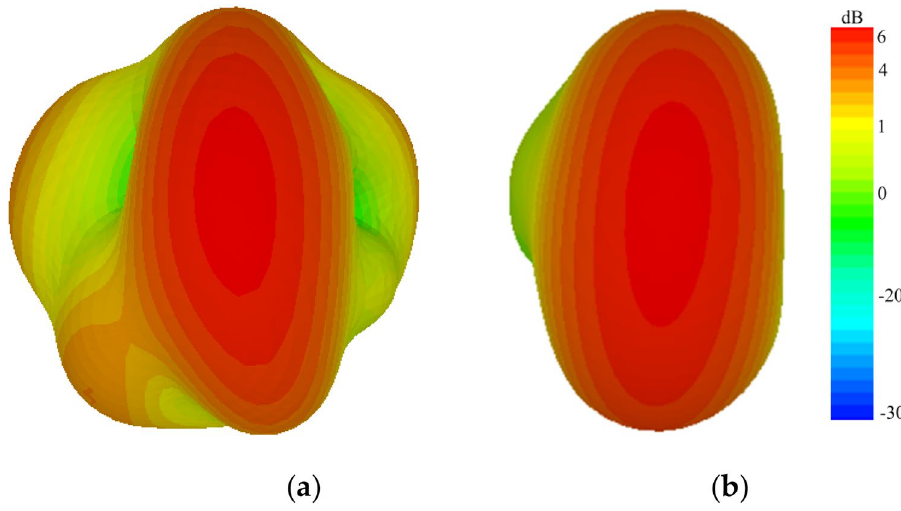
Figure 6. 3D Radiation patterns ( a ) Simple MIMO antenna ( b ) Proposed MIMO